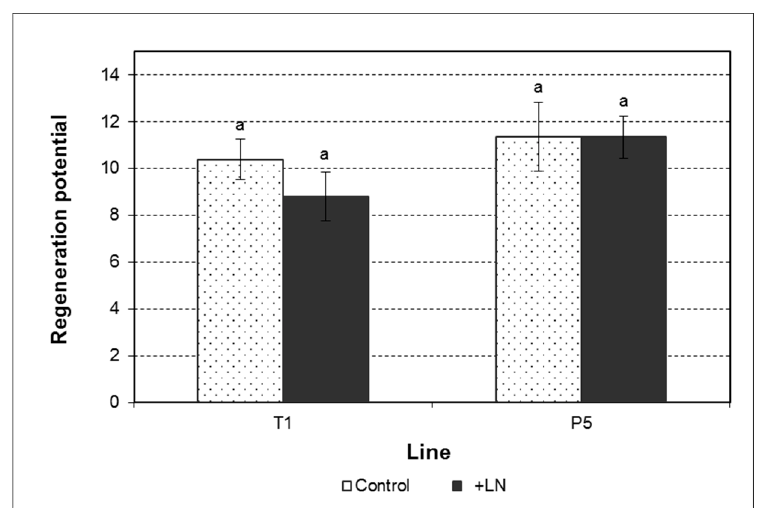
Figure 2. Regeneration potential of control and cryopreserved embryogenic cultures of the lines T1 and P5. Data represent the mean ± SEM. Different letters indicate significant differences by the least significant difference (LSD) test with a significance level of 0.05.